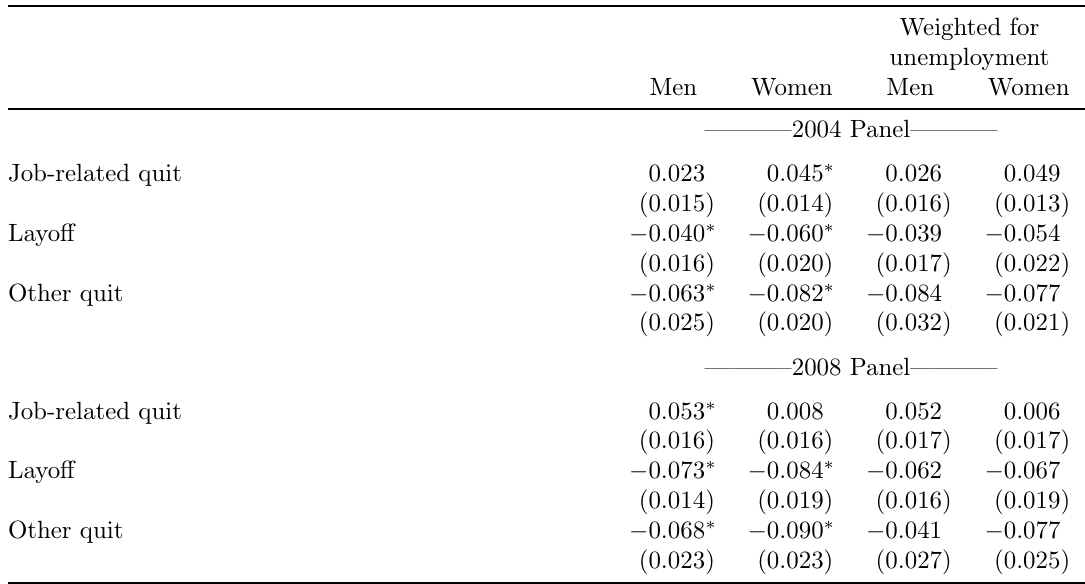
Table 3: Fixed effects regression coefficients for the effect of job mobility on the log of monthly